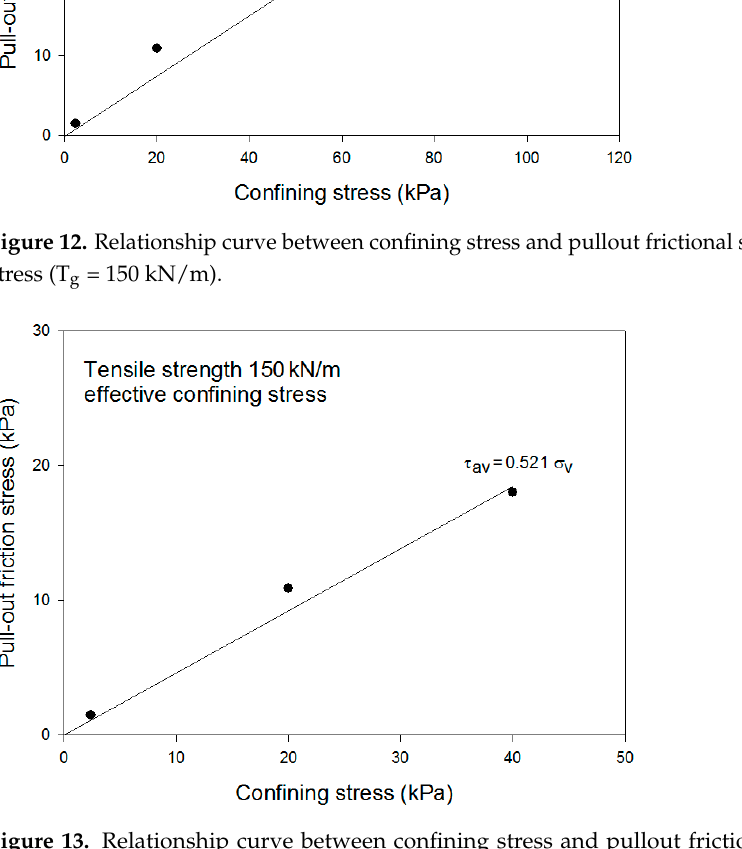
Figure 13. Relationship curve between confining stress and pullout frictional stress by effective confining stress (T g = 150 kN/m).